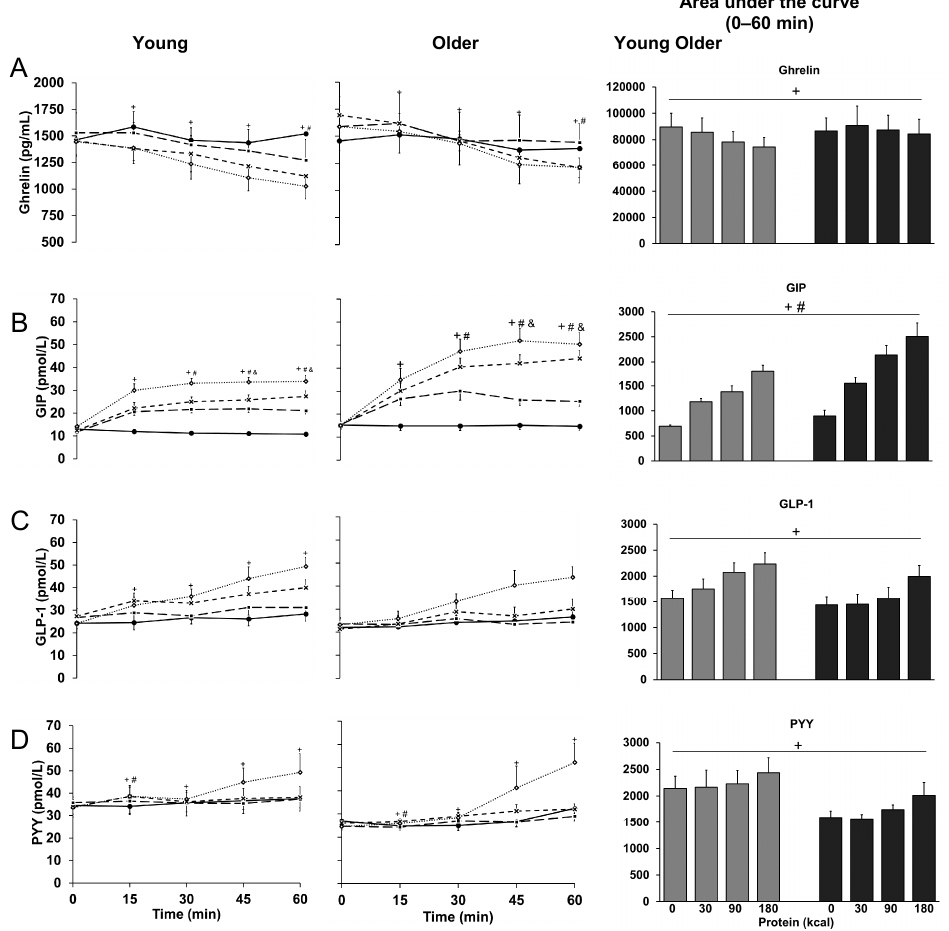
Figure 3. Mean (±SEM) and area under the curve concentrations of plasma ghrelin ( A ), gastric inhibitory peptide (GIP) ( B ), glucagon-like peptide-1 (GLP-1) ( C ), and peptide tyrosine-tyrosine (PYY) ( D ), in healthy younger ( n = 10 for ghrelin and PYY; n = 9 for GIP and GLP-1) and older ( n = 10) men during intraduodenal infusions of saline (control; solid line with closed circles) and whey-protein loads of 30 kcal (7.5 g protein; dashed line with closed squares), 90 kcal (22.5 g protein; dashed line with crosses), and 180 kcal (45 g protein; dotted line with open diamonds). Effect of protein-load, age, and the interaction-effect of protein-load by age were determined using a mixed-effect model with baseline concentrations as a covariate and post-hoc Bonferroni correction; statistical significance was accepted at p < 0.05. + p < 0.05 Effect of protein-load. Post-hoc tests: higher